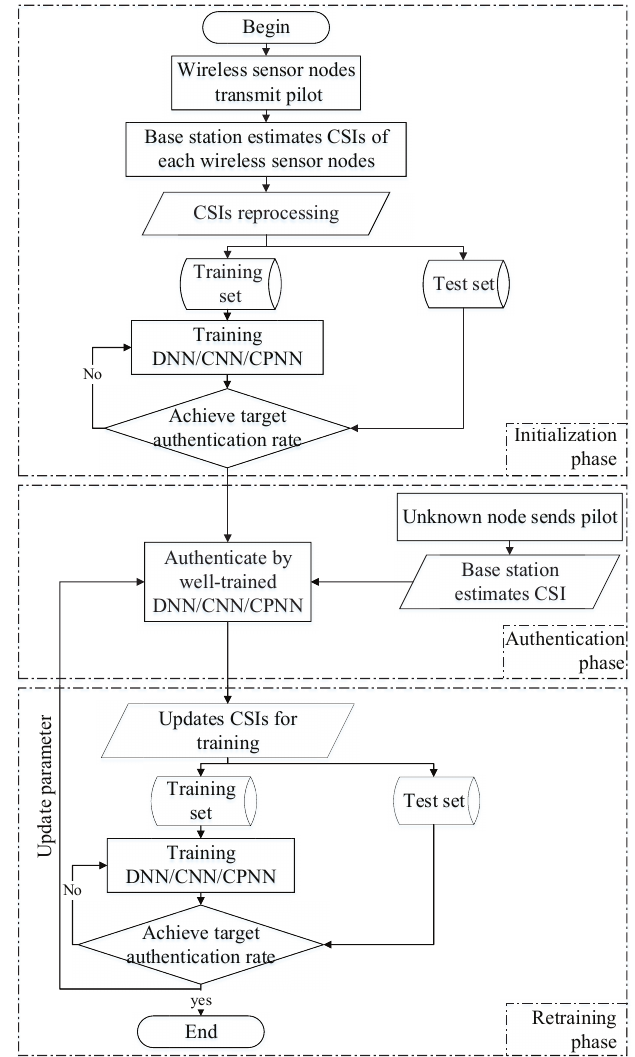
Figure 4. DL-based PHY-layer authentication flow